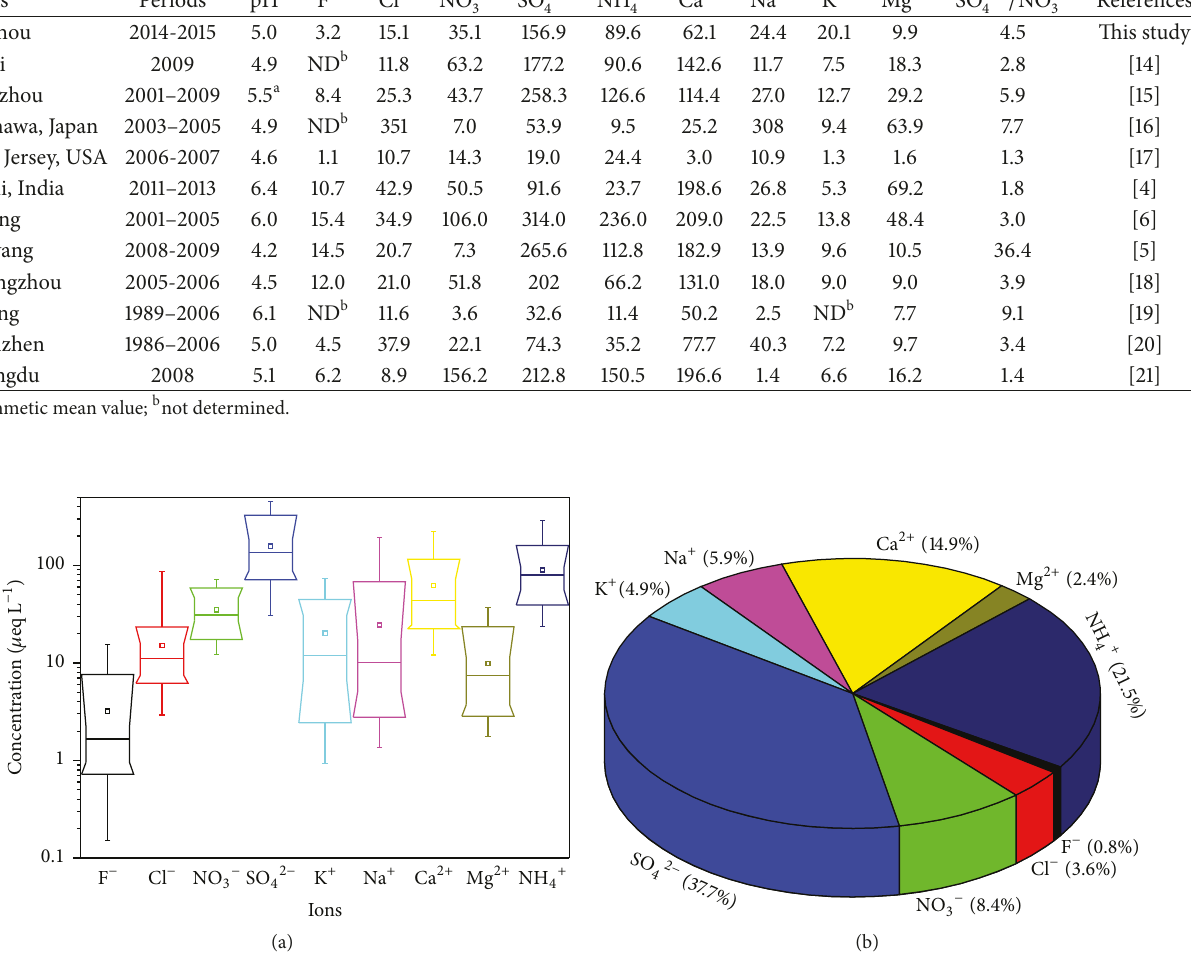
Figure 3: (a) Statistics of ions’ concentration and (b) percentages of ions’ VWM concentration ( 𝜇 eq L −1 ) in the precipitation in Wanzhou. The box plots indicate the minimum, 10th and 25th percentiles, median, 75th and 90th percentiles, maximum, and average (square) of each